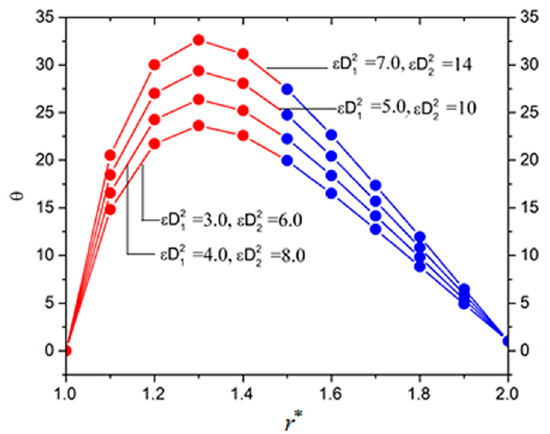
Coatings 2018 , 8 , x FOR PEER REVIEW